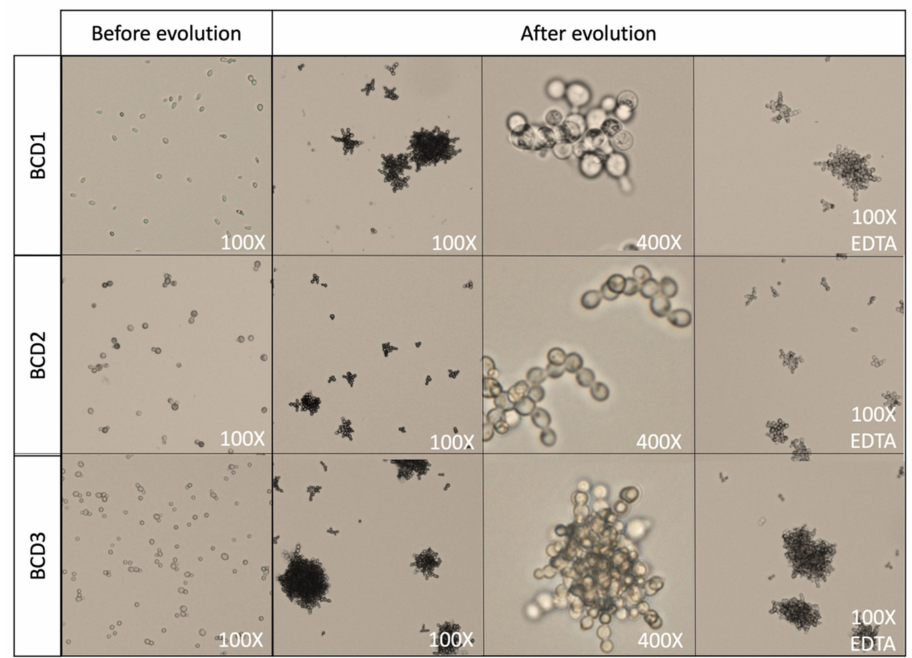
Figure 3. Microscopic observations of the industrial strains before and after the evolution in the ministats. Snowflake clumps are observed for each strain and could not be disrupted by treatment with 50 mM